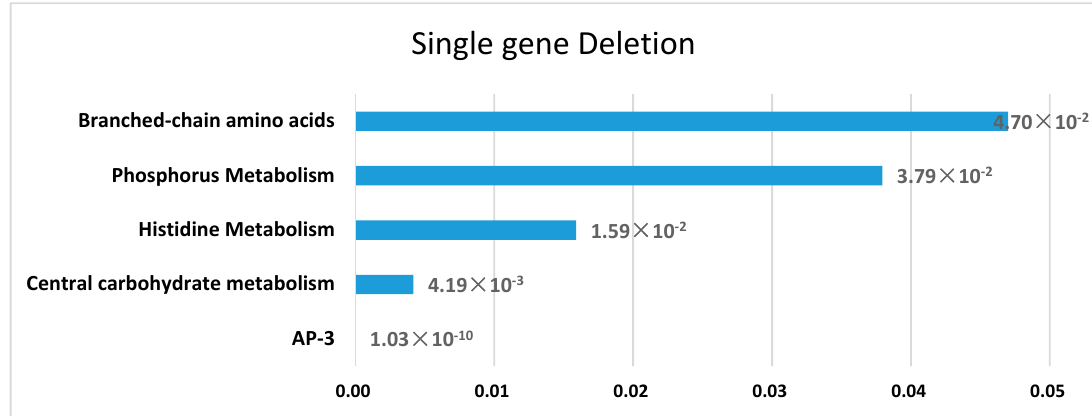
Figure 3. Enriched pathways of the genes essential for ansamitocin P-3 (AP-3) biosynthesis. The vertical axis represents enriched pathways, and the horizontal axis represents the p -value of each pathway.